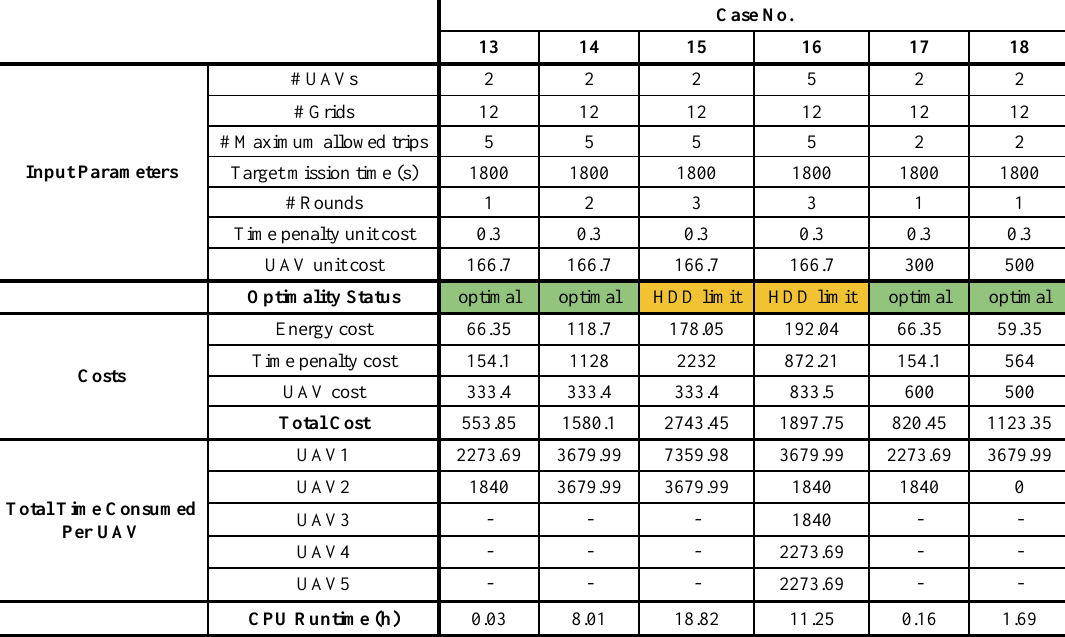
Table 7. Results on the grid problems with different maximum allowed trips and